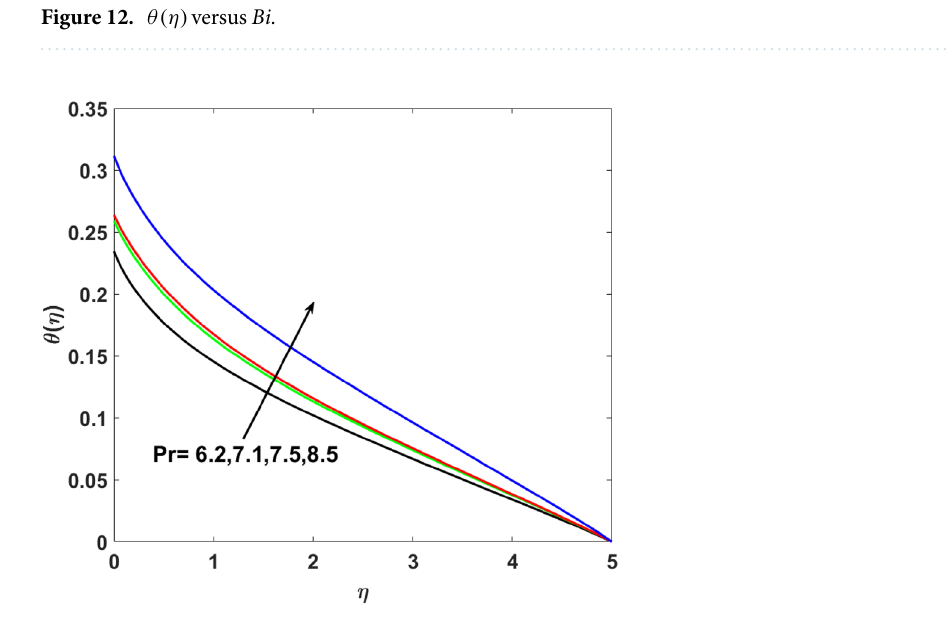
Figure 13. θ(η) versus Pr